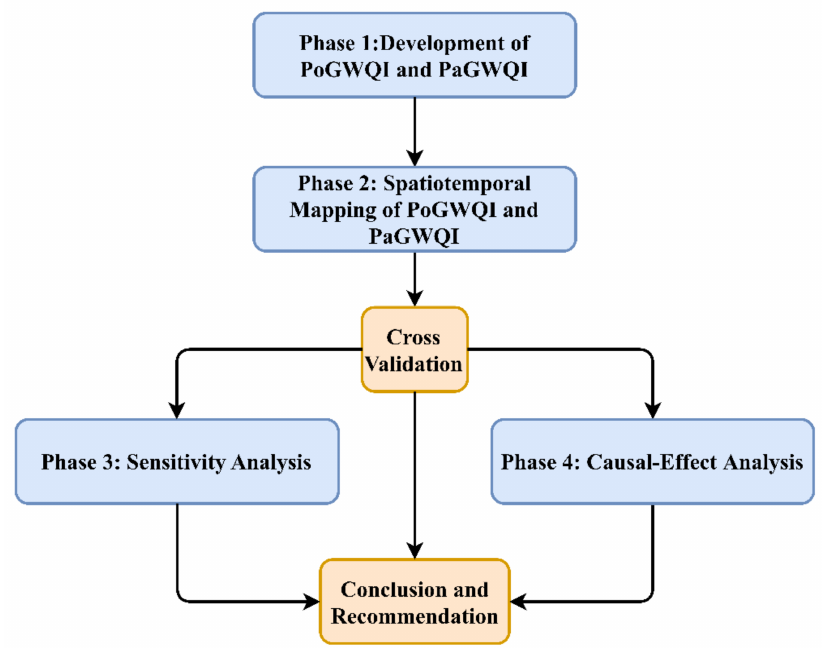
Figure 1. Overall methodological framework.